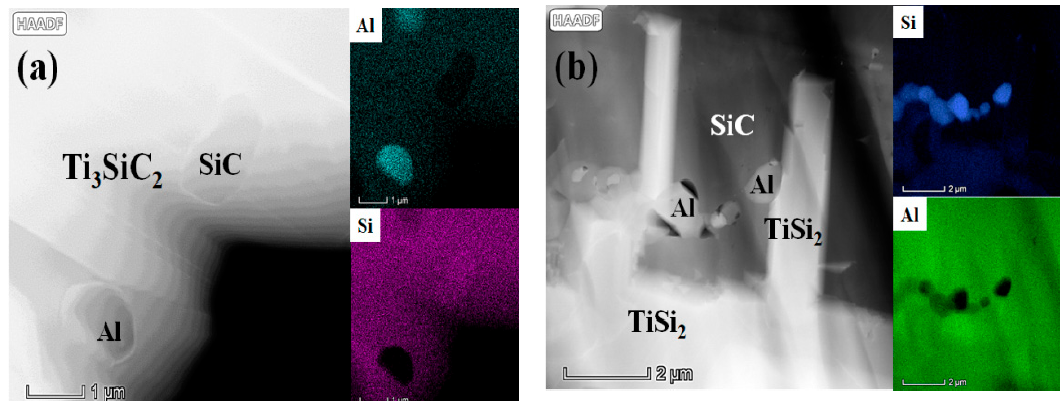
Figure 3. HAADF and EDS imaging images ( a ) showing Ti 3 SiC 2 , Al, and SiC and ( b ) showing TiSi 2 , Al, and SiC.